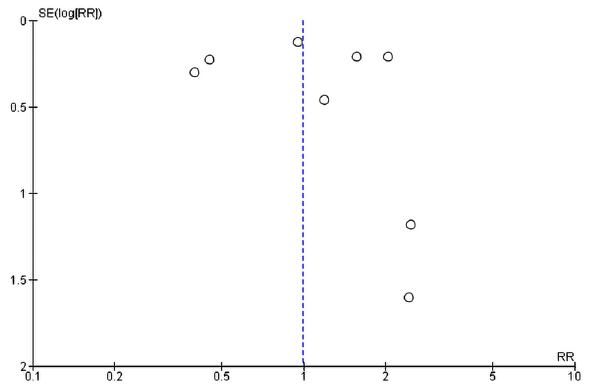
Figure 4. Funnel plot of included studies highlighted the mortality of the Hydroxychloroquine